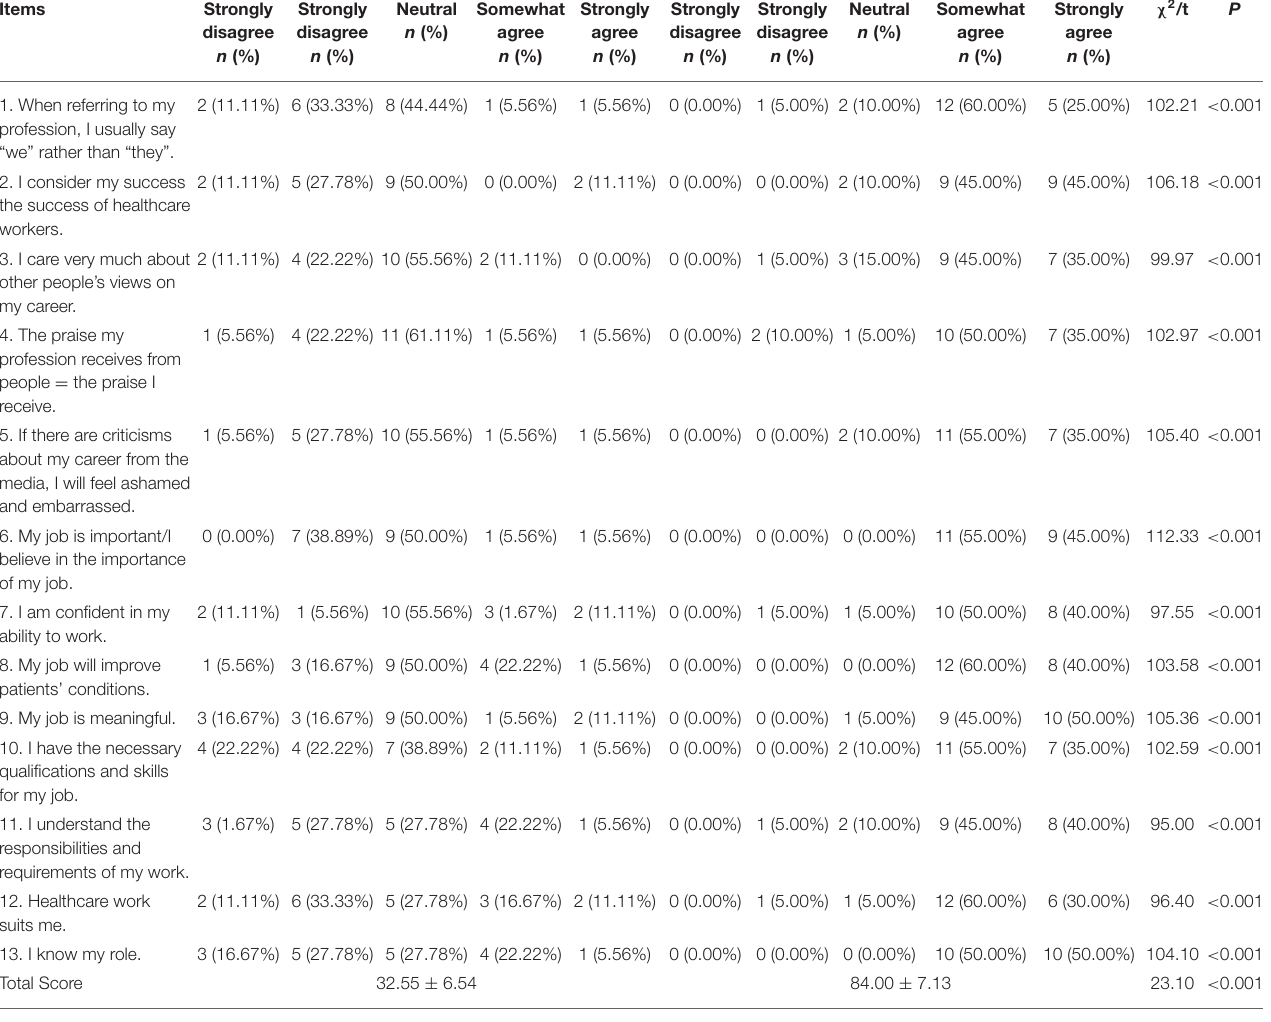
Control group ( n = 18) Intervention group ( n = 20)